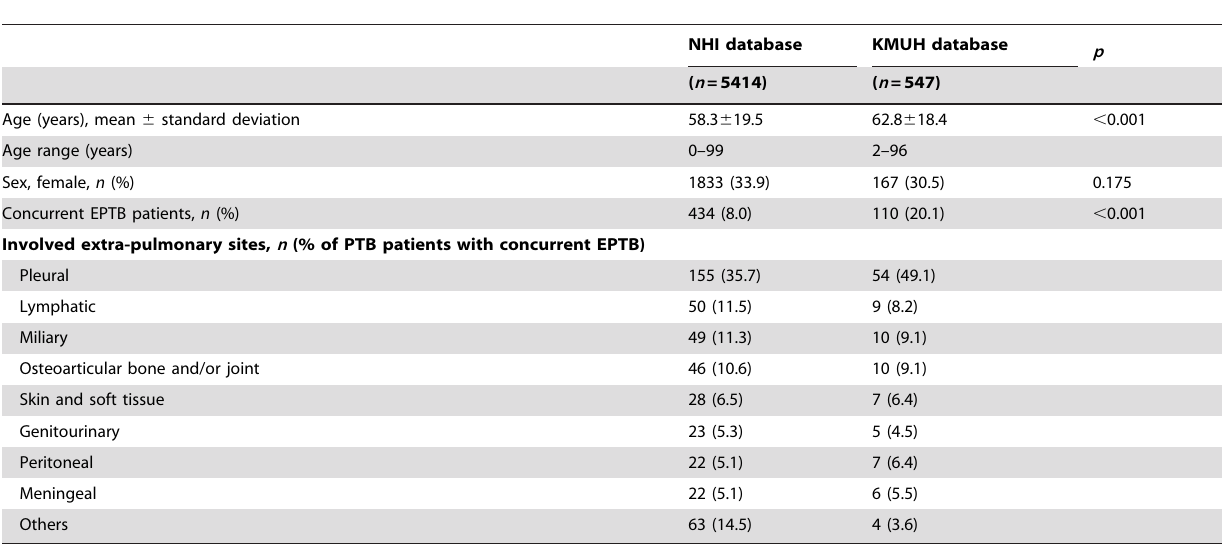
Table 1. Demographic characteristics of PTB patients, from the NHI database ( n =5414) and KMUH database ( n = 547).